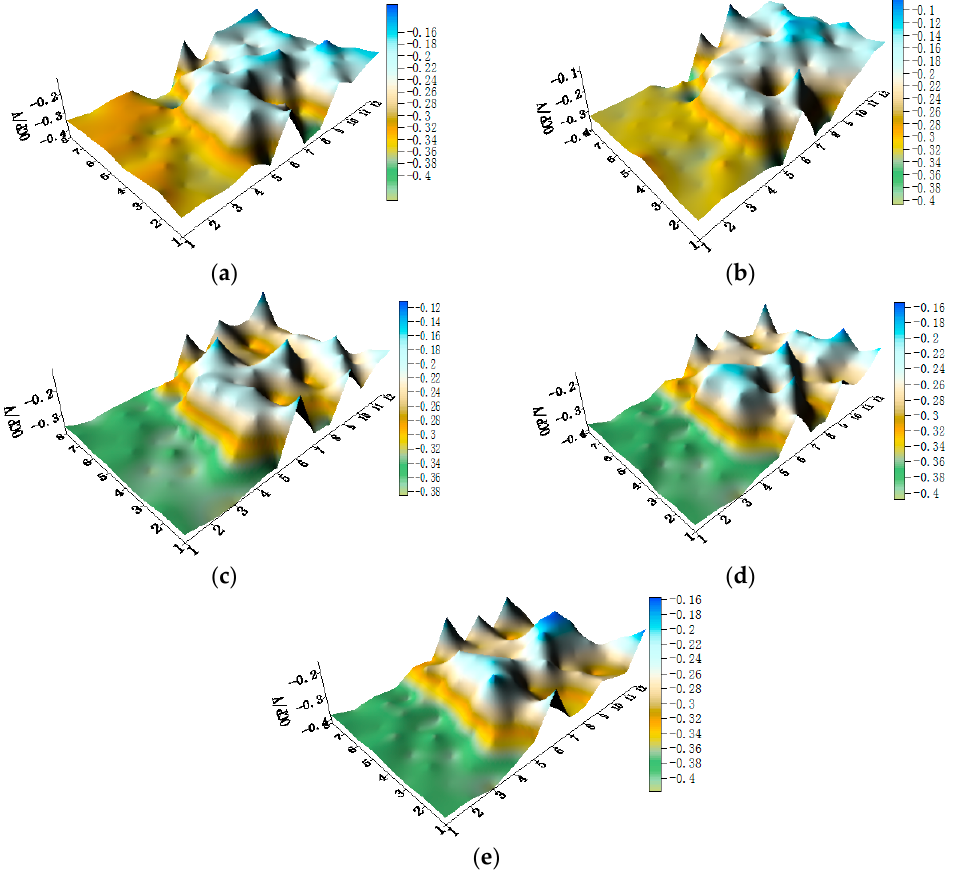
Figure 3. Open circuit potential OCP (vs. saturated calomel electrode (SCE)/V) distribution maps of the WBE1 (HAl77-2/316L SS/TA2) after immersion in artificial seawater at different temperatures: ( a ) 30 °C; ( b ) 40 °C; ( c ) 50 °C; ( d ) 60 °C; and ( e ) 70 °C.